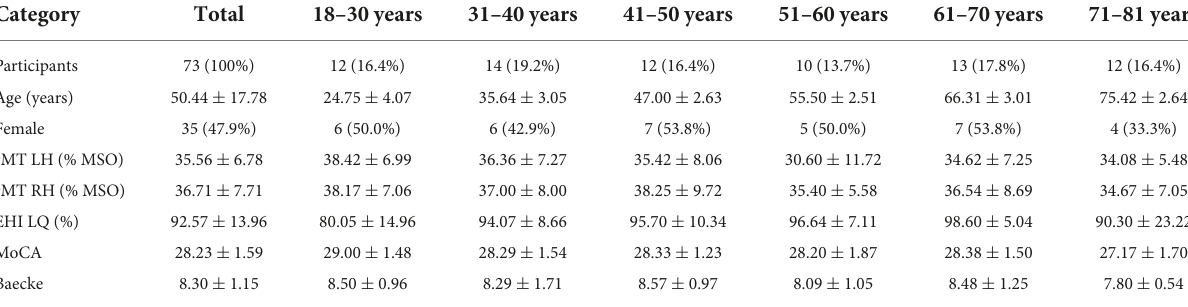
TABLE 1 Participant